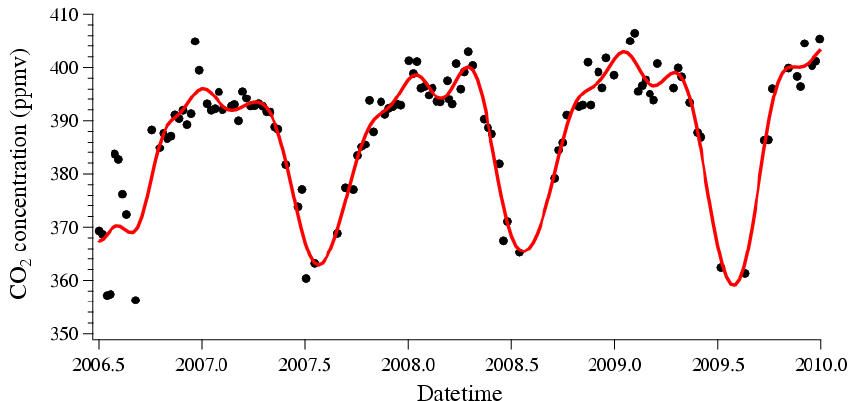
Fig. 1. Time series of the CO 2 measurements at Longfengshan (LFS) in Northeast China: black points indicate weekly flask observations; red line indicates a curve fitted to the 818 measurements. 819